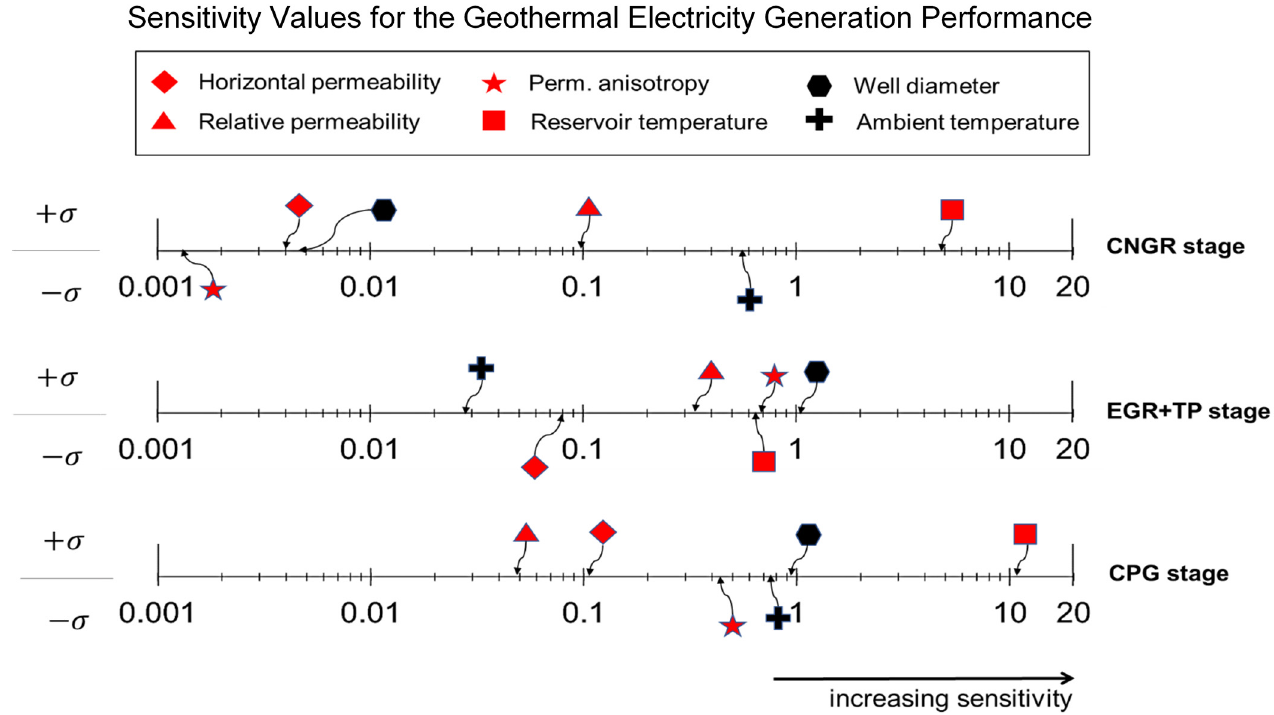
Figure 6. Sensitivity values (plotted on a logarithmic axis) for the geothermal electricity generation performance metric for the reservoir and operational parameters considered in this study. This is calculated for the three main stages of the combined system. The positive ( upper ) part signifies that an increase in the parameter values will increase the geothermal power output. The negative ( lower ) part identifies parameters that, when being increased, will result in a decrease in the geothermal power output.